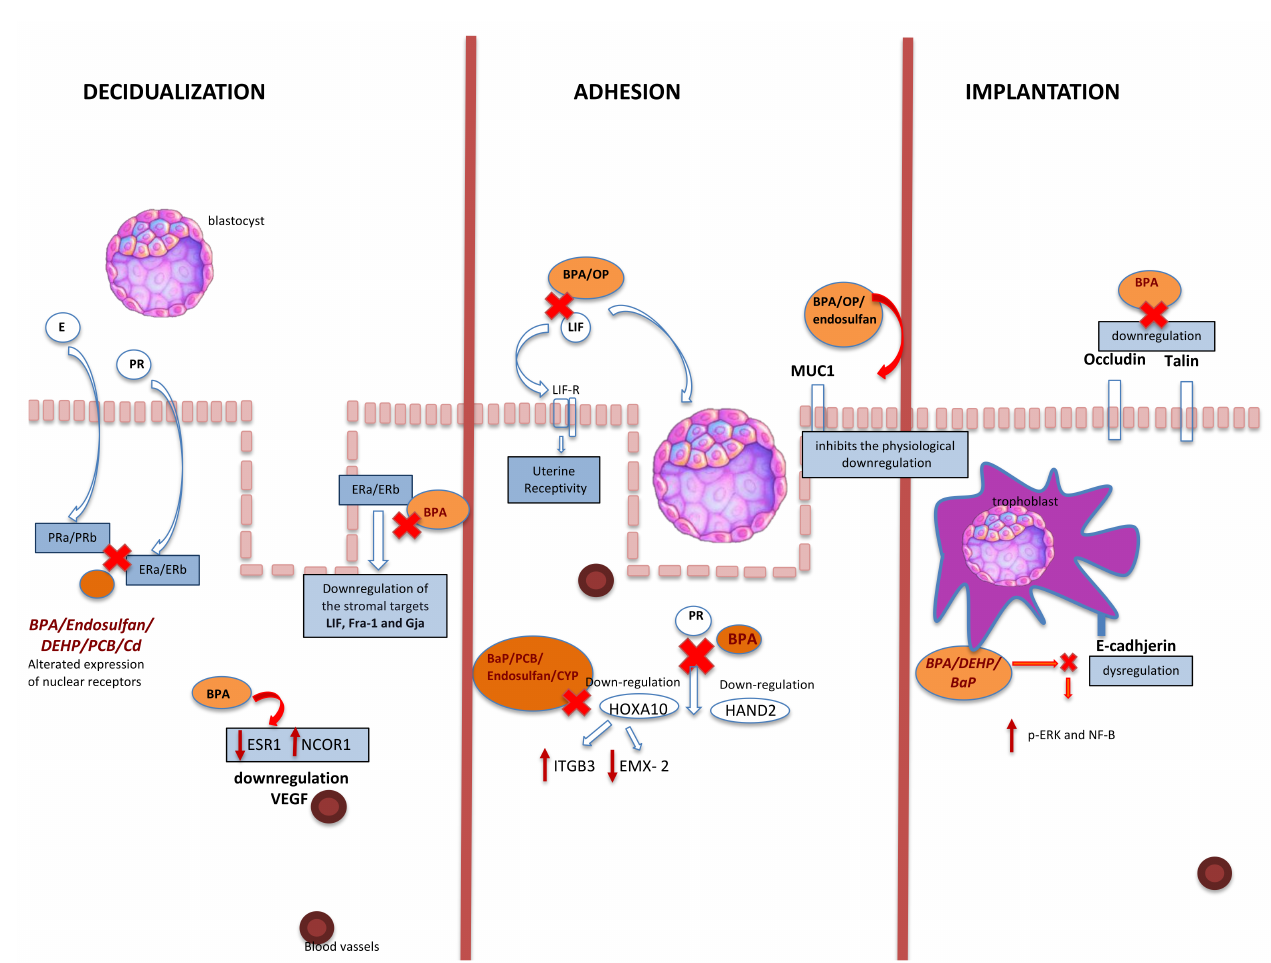
Figure 3. Association between EDC and embryo implantation. BPA: bisphenol A; PR: progesterone; E: estrogen; PRa/b: progesterone receptor; ERa/ERb: estrogen receptors: EP: epithelial cell (luminal and glandular epithelia); HOXA10: homeobox 10; Hand2: heart- and neural crest derivatives-expressed protein 2; LIF: leukemia inhibitory factor; LIFR: LIF receptor; DEHP: di-(2-ethylhexyl)-phthalate; VEGF: vascular endothelial growth factor; MUC1: mucin1; DEHP: di-(2- ethylhexyl) phthalate; PCB: 2,30,4,40,5-pentachlorobiphenyl; Cd: cadmium; ITGB3: integrin subunit beta 3; EMX-2: empty spiracles homeobox 2; OP: 4- tert -octylphenol; BaP: benzo(a)pyrene; CYP: cypermethrin; CP: β -cypermethrin; p-ERK: phosphorylation extracellular signal-related kinase NF-KB: nuclear factor-KB; NCOR1: nuclear receptor corepressor 1; ESR1: estrogen receptor